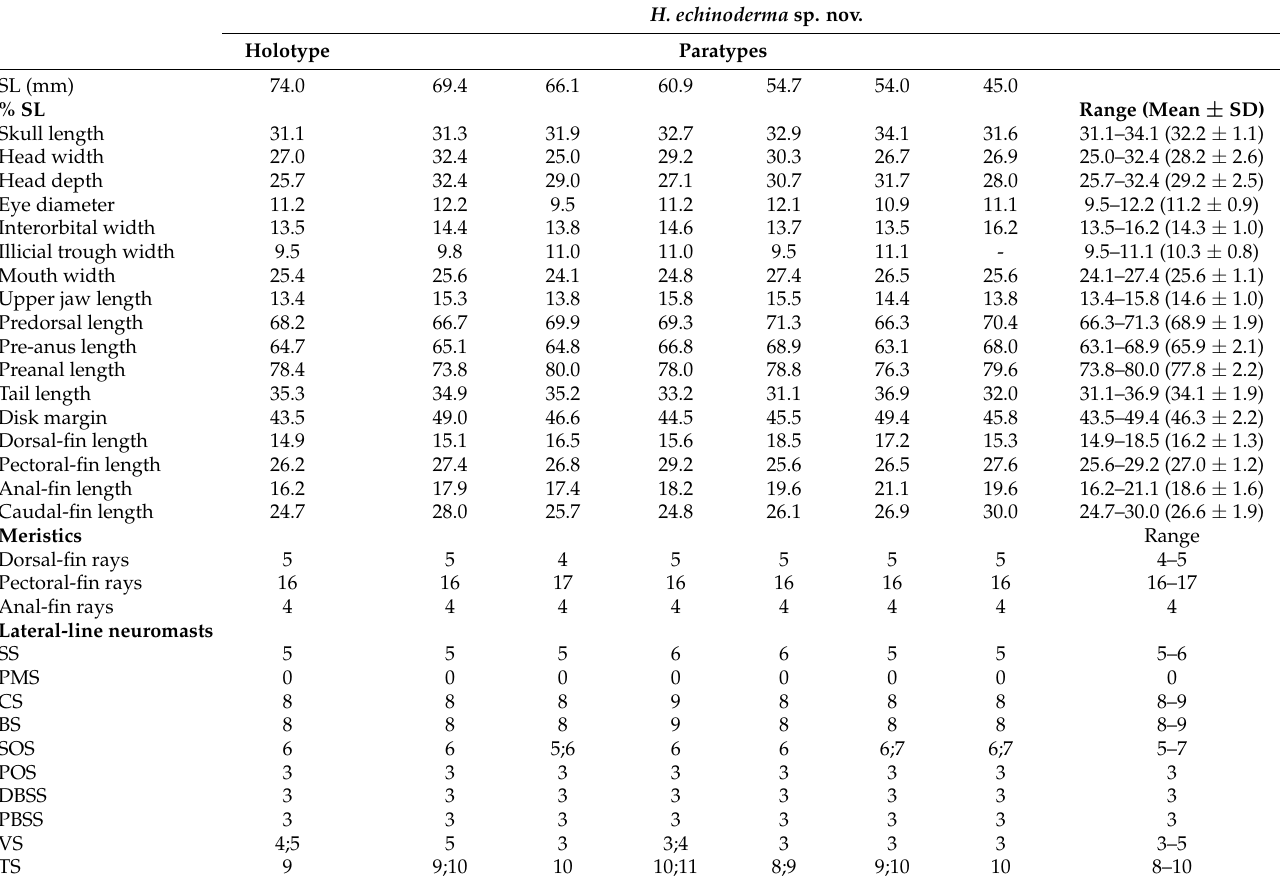
Table 4. Morphometric and meristic data of H. echinoderma sp. nov. H. echinoderma sp.